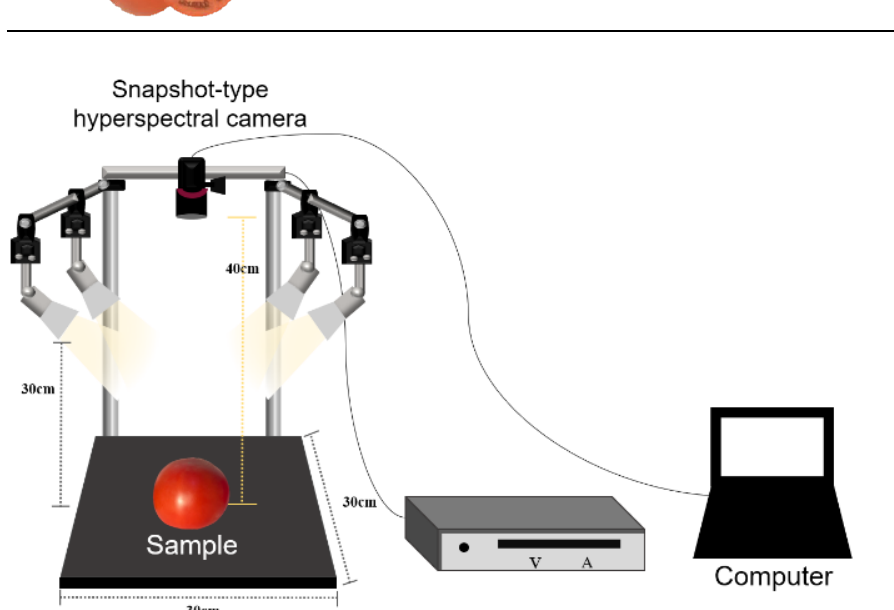
Figure 1. The schematic diagram of hyperspectral image acquisition system.